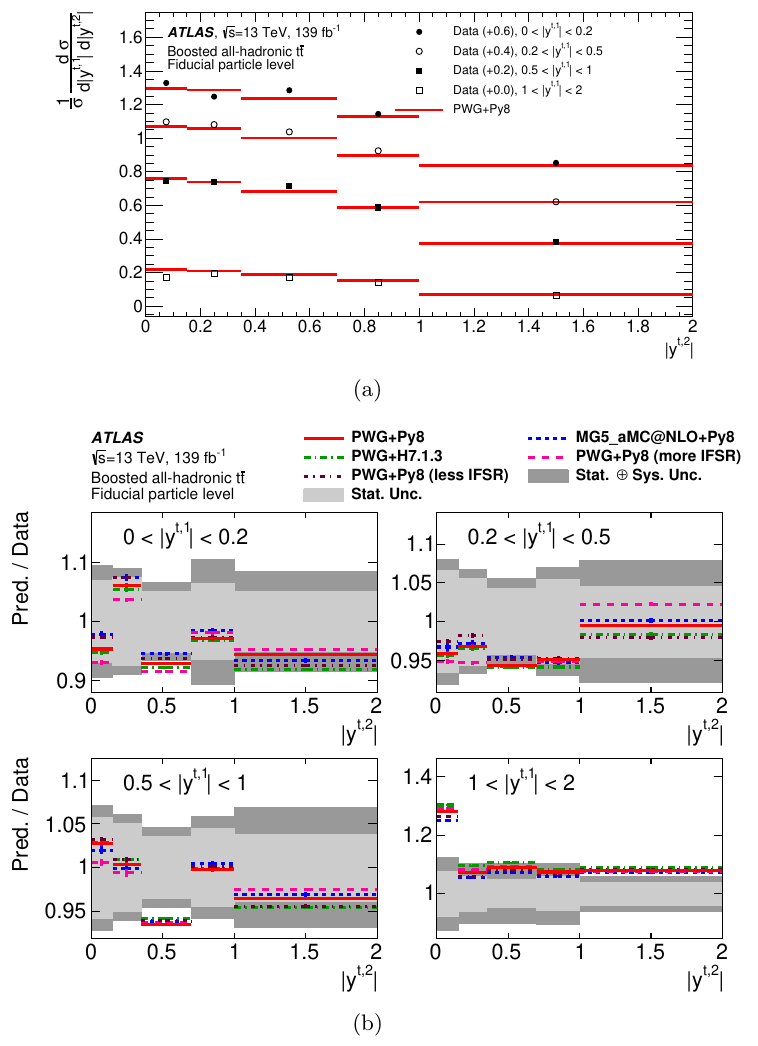
Figure 39 . (a) Normalized particle-level fiducial phase-space double-differential cross-sections as a function of the absolute value of the rapidity of the leading and the second-leading top-quark jet, compared with the Powheg+Pythia 8 calculation. Data points are placed at the centre of each bin and the Powheg+Pythia 8 calculation is indicated by solid lines. The measurement and the prediction are shifted by the factors shown in parentheses to aid visibility. (b) The ratios of various MC calculations to the normalized particle-level fiducial phase-space differential cross-sections. The dark and light grey bands indicate the total uncertainty and the statistical uncertainty, respectively, of the data in each